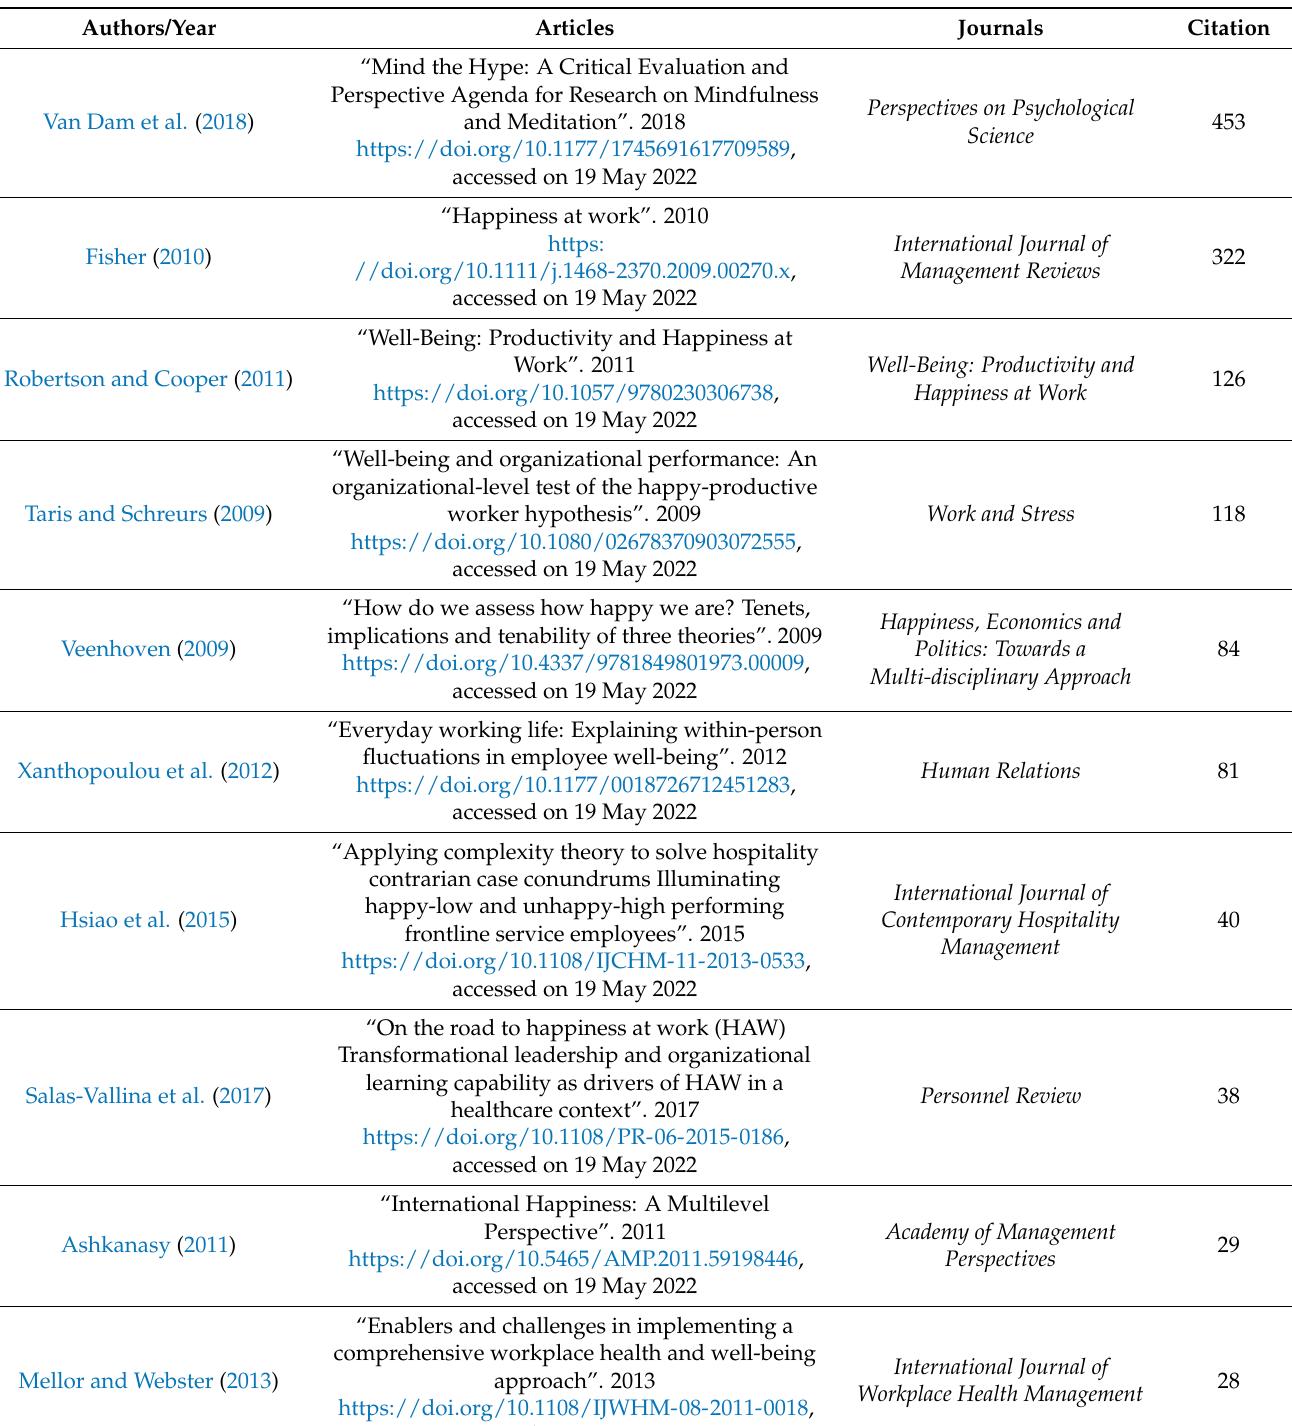
Table 4. Articles with the highest numbers of